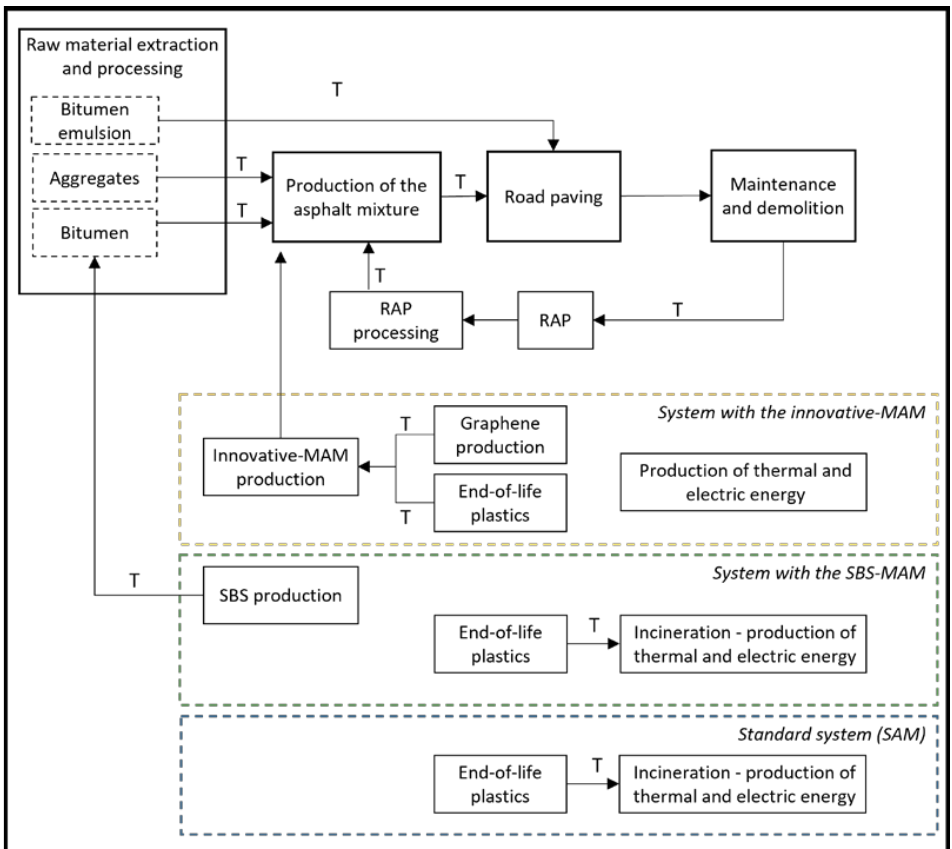
Figure 1. System boundaries of the analysis. The three dashed boxes correspond to the three systems under comparison. Yellow: system with the innovative-MAM; Green: System with the SBS-MAM; Blue: Standard system SAM. T stands for transport processes.